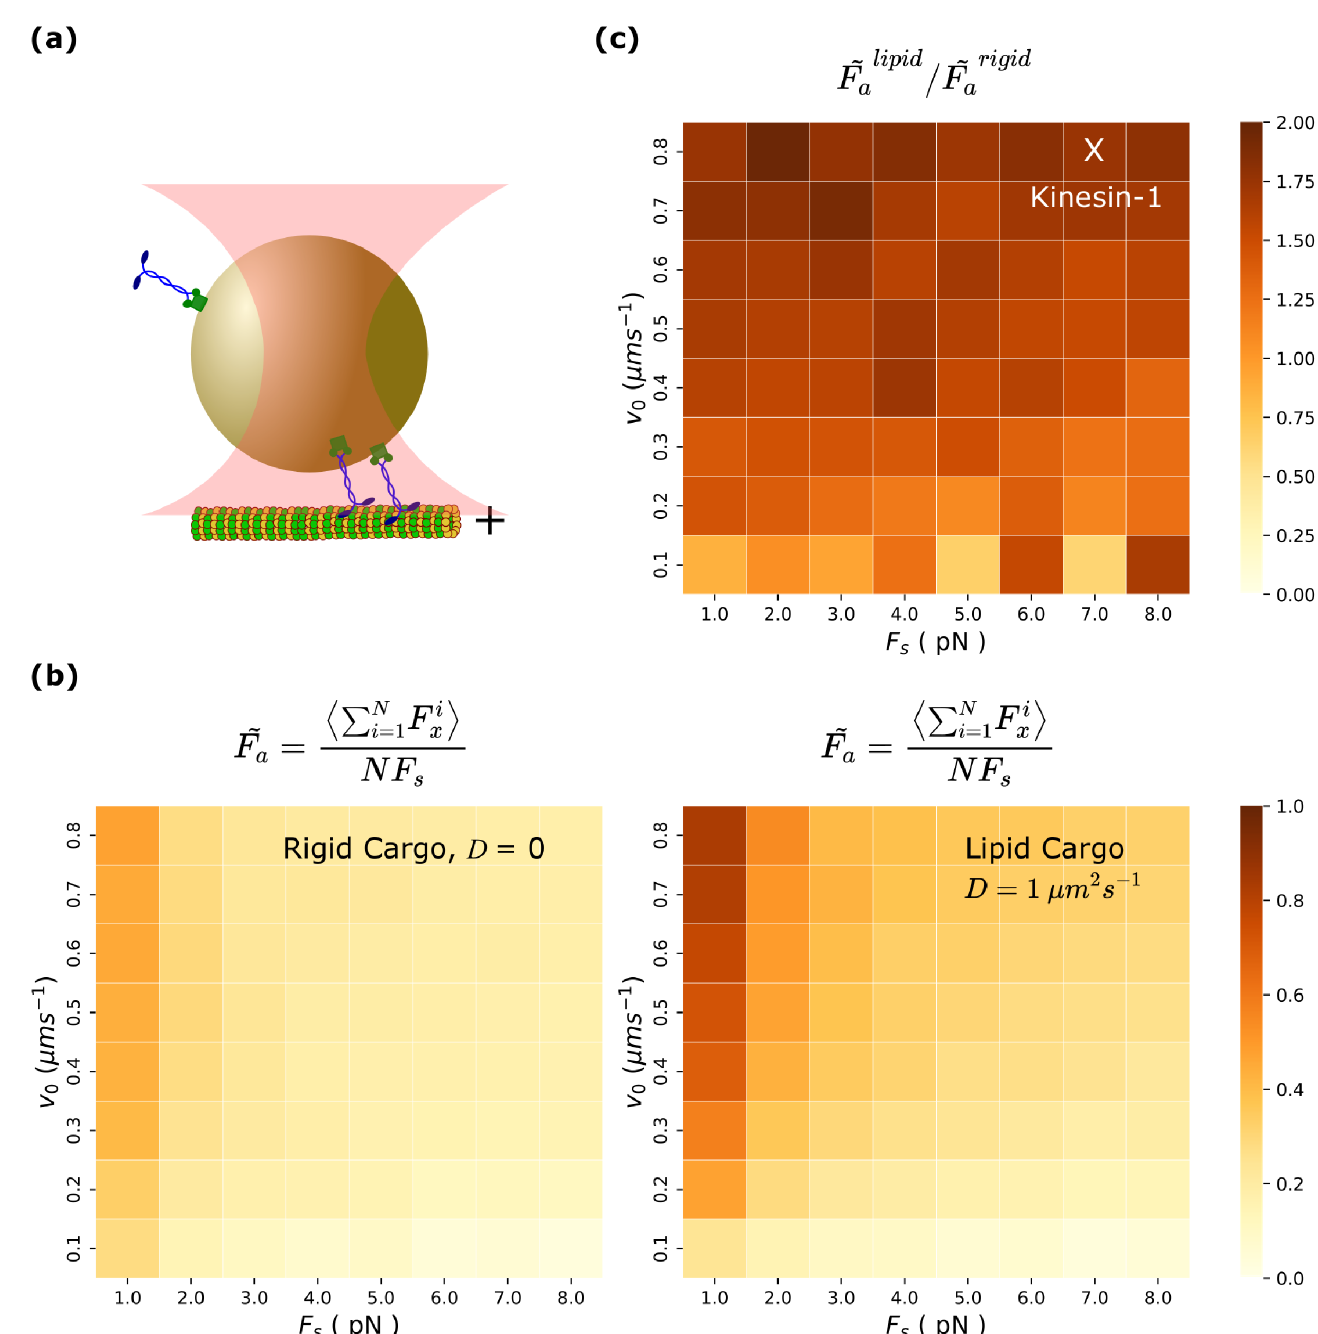
Fig 7. Motor teams in fluid cargoes generate higher collective forces. (a) Schematic of the optical trap set up that we used in simulation. (b) Rescaled average �P � N i x collective force ~ F ¼ as a function of unloaded motor velocity ( v 0 ) and stall force of motor ( F i ¼ 1 F a NF s between lipid and rigid cargo. 200 cargo runs were used for each parameter set. For each cargo run, data of motor forces for each microtubule bound motors were recorded at a sampling rate of 100/s for a maximum time of 10 s for each cargo run. Average collective force is calculated as the average of the total x-component of motor forces over all time samples and cargo runs and then rescaled by NF s . N = 4 and [ATP] = 2 mM.